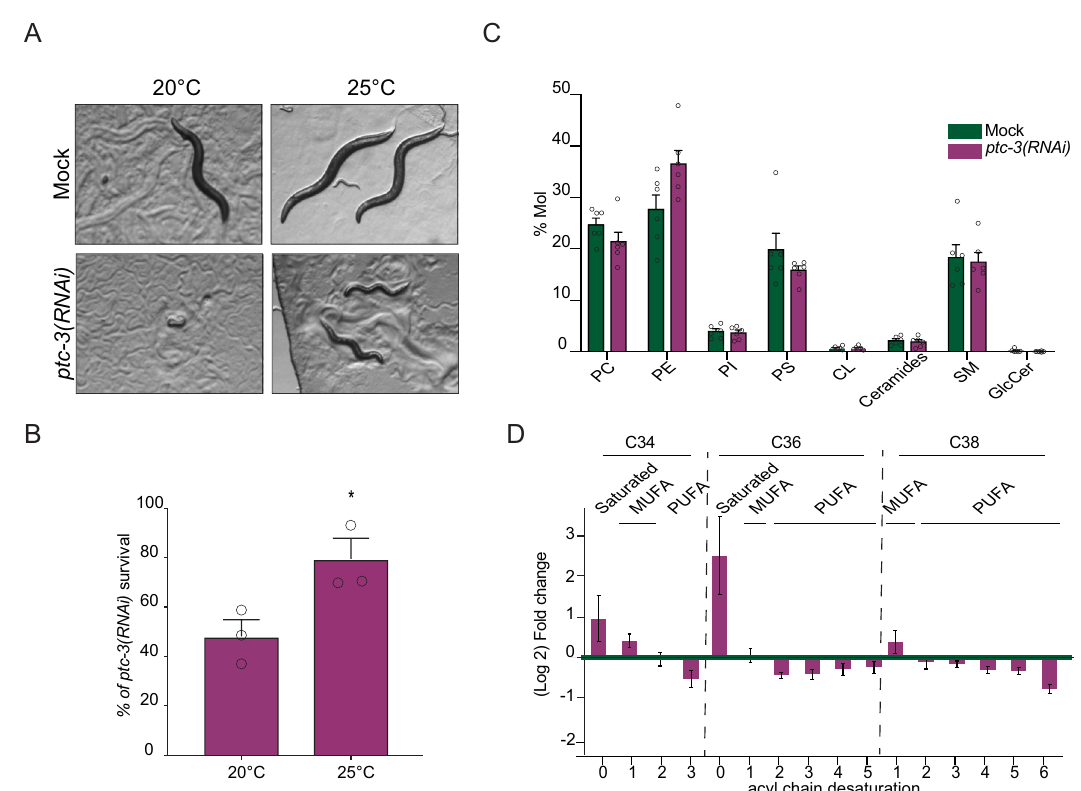
Fig. 5 ptc-3(RNAi) decreases phospholipid FA saturation and elongation. A Increasing the growth temperature from 20 °C to 25 °C improves the development of ptc-3(RNAi) animals. Representative bright- fi eld pictures of worms on growth plates. B Quanti fi cation of ptc-3(RNAi) survivors at both temperatures. Mean and SEM error bars, unpaired one-tailed T test, = 197 (20 °C) and 246 (25 °C) animals from three independent experiments * p = 0.02. C Lipidomics on mock or RNAi-treated worms. ptc-3(RNAi) worms showed minor differences in lipid head group distribution. Mean and SEM error bars, n = 6. D Lipidomics revealed differences in lipid acyl chain composition upon ptc-3(RNAi) . There is a shift from PUFAs to saturated FA and MUFAs. Mean and SEM error bars, each point represents the average of six experiments per lipid type. Statistical source data are available as source